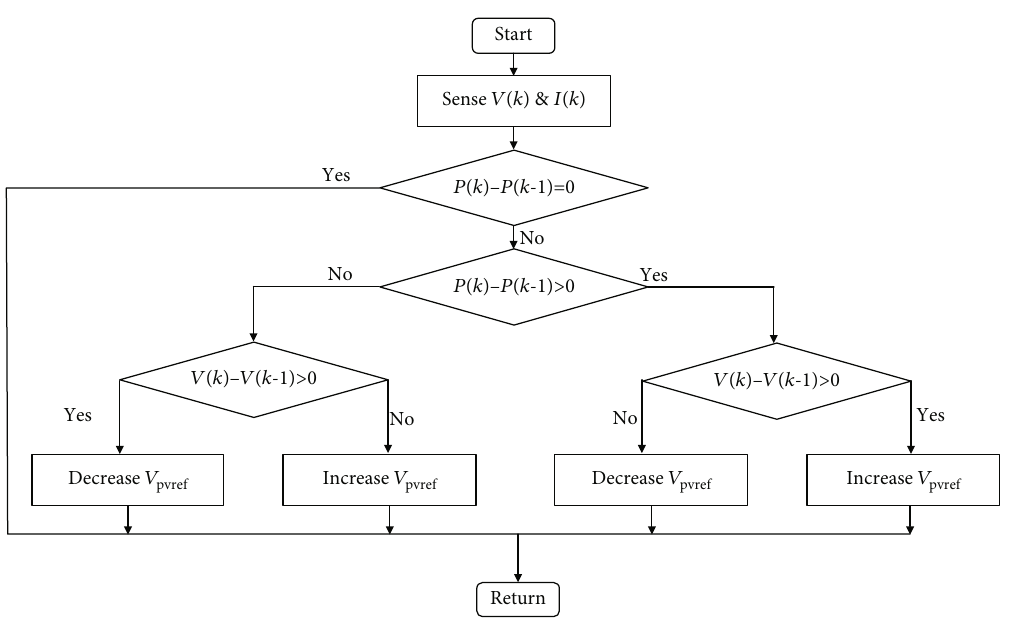
Figure 4: Flowchart of the P&O algorithm.